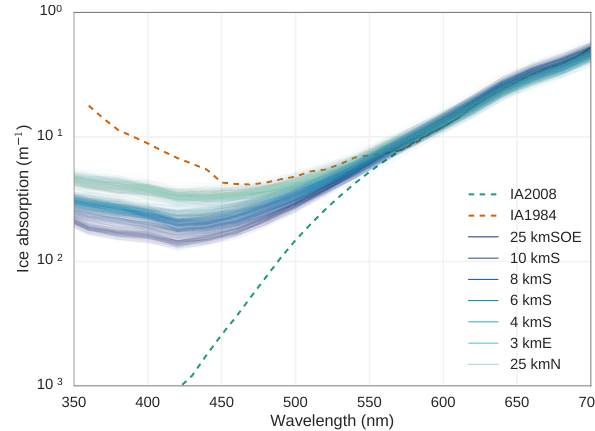
Figure 7. Ice absorption estimated by the BAY method at different locations around around Concordia.